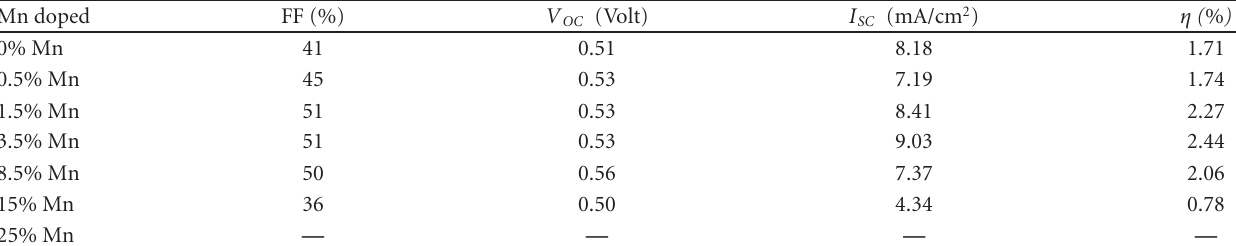
Figure 6: J-V characteristic curves for TiO 2 - and Mn-doped TiO 2 solar cells under illumination. Table 1: Designed solar cells power conversion parameters.